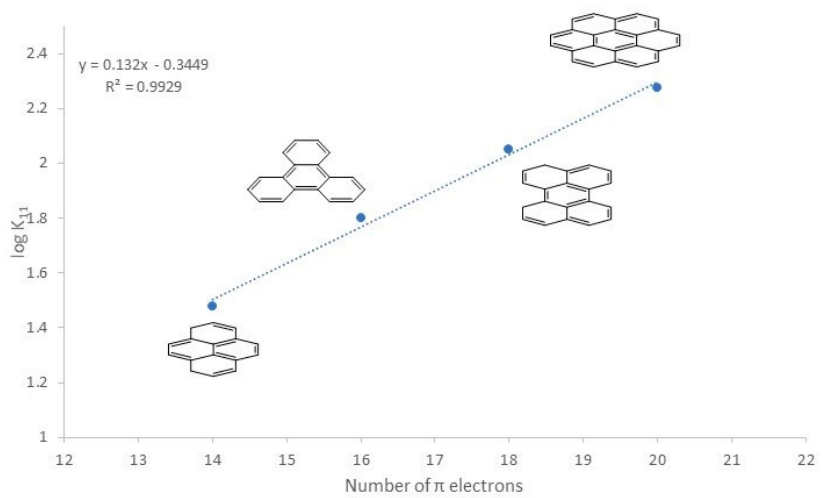
Figure 2. Plot of the association constants (K 11 ) in CHCl 3 between 2 and the number of π -electrons of the rich PAHs used in this